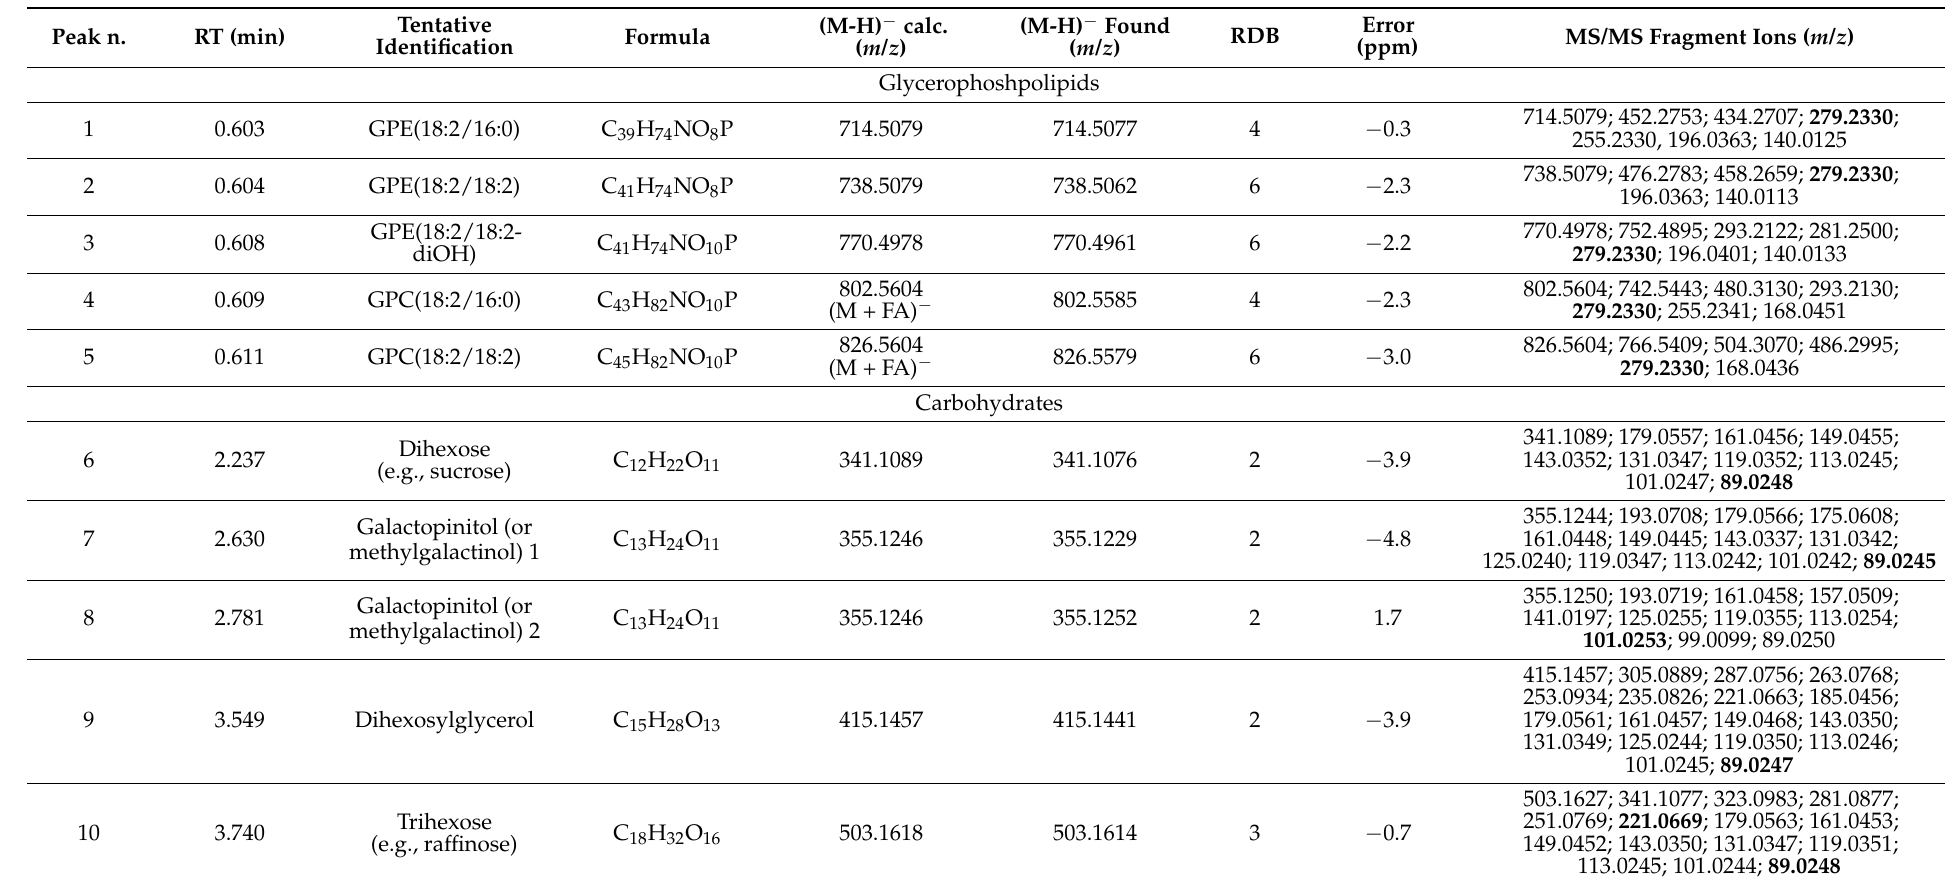
Table 3. TOF-MS and MS 2 data of compounds tentatively identified in Cf-W extract (RDB = Ring and Double Bond; FA = Formate Anion; GPE = glycerophosphoethanolamine; GPC = glycerophosphocholine). Base peaks in MS/MS spectra are reported in bold. Peak